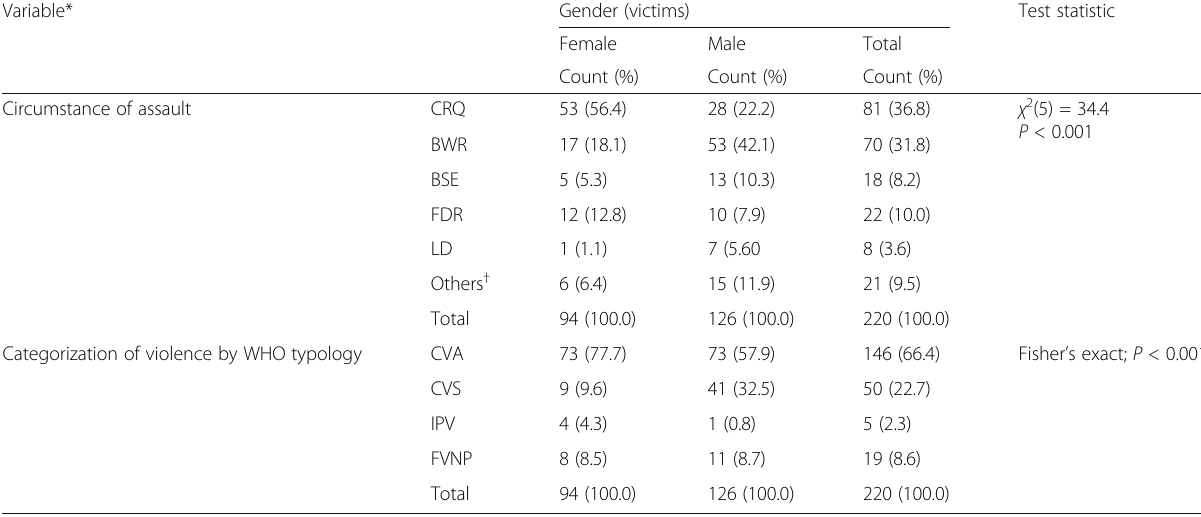
Table 3 The circumstance of assault and typology of violence studied according to the gender of the victims of non-fatal interpersonal